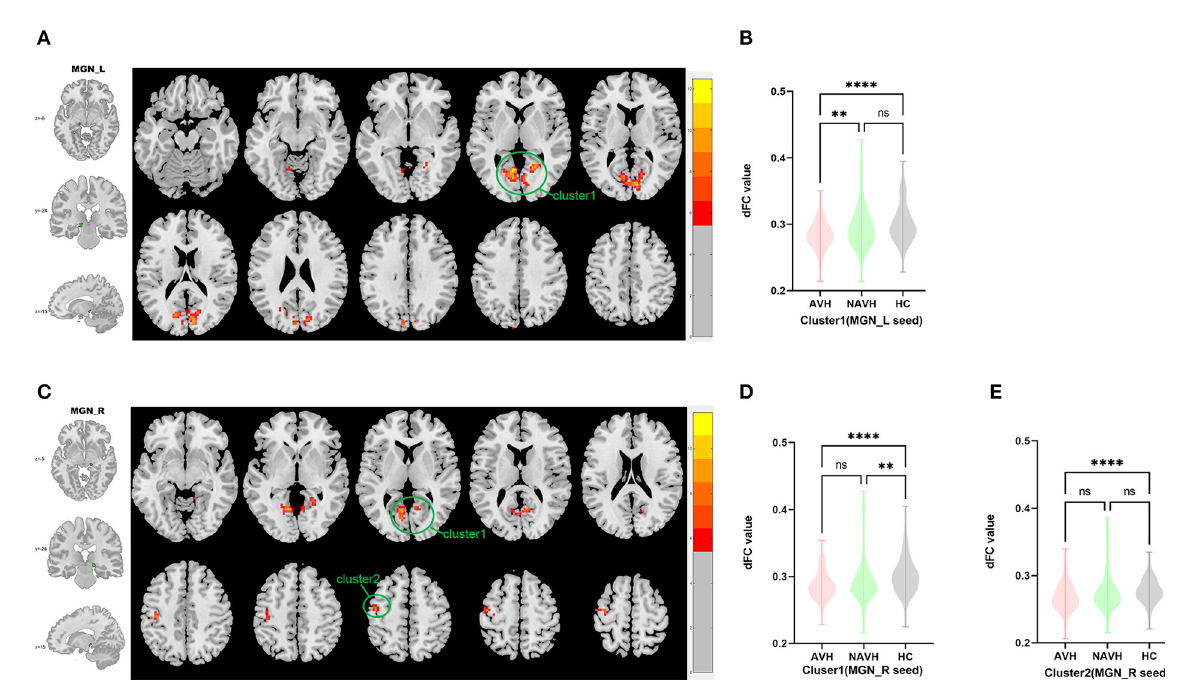
FIGURE3 Brain regions showing abnormal dFC values among AVH, NAVH and HC groups in MNI space using left and right MGN as seeds. (A) Significant dFC value differences were observed in cluster1 (bilateral calcarine gyrus, bilateral cuneus gyrus, bilateral lingual gyrus) using left MGN as seed. (B,C) Altered dFC values in cluster1 among AVH, NAVH and HC groups using left MGN as seed. (D) Significant dFC value differences were observed in cluster1 (bilateral calcarine gyrus, bilateral cuneus gyrus, bilateral lingual gyrus) and cluster2 (left precentral gyrus and left postcentral gyrus) using right MGN as seed. (E,F) Altered dFC values in cluster1 among AVH, NAVH and HC groups using right MGN as seed. ****Significant at 0.0001